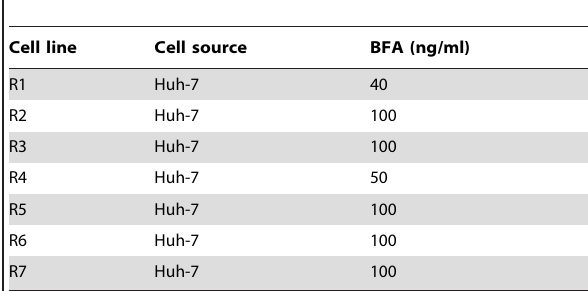
Table 1. Selection of BFA-resistant cell